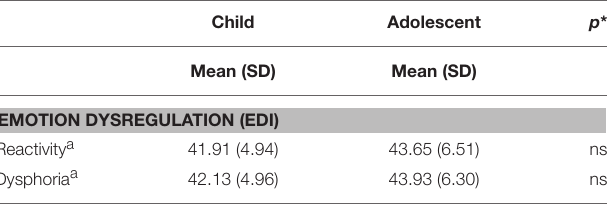
a T-scores. * Pairwise comparisons between estimated marginal means, controlling for